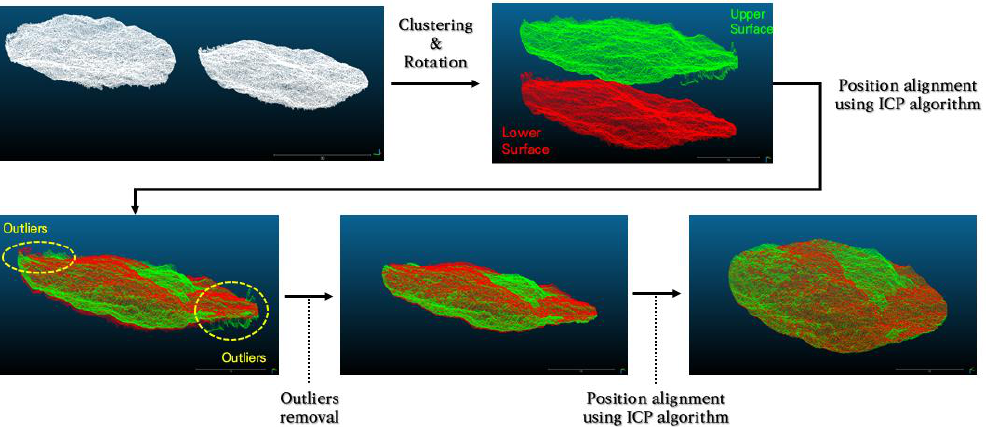
Figure 4. Schematic of an algorithm for primary matching according to the shape of the fracture